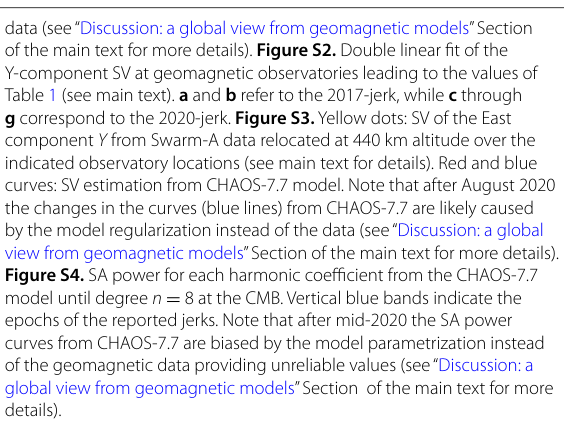
Fig. 5 Maps of the secular acceleration (SA) of the radial field Br at the CMB and the spatial average of its square value given by the black curve. Maps in a February‑2016 and b September‑2018 correspond to the two maxima observed in the black curve (yellow squares). Map in c June‑2017 corresponds to the minimum presented in the black curve (green square) and map in d June‑2020 is plotted at the end of the time window (red square) where the black curve is